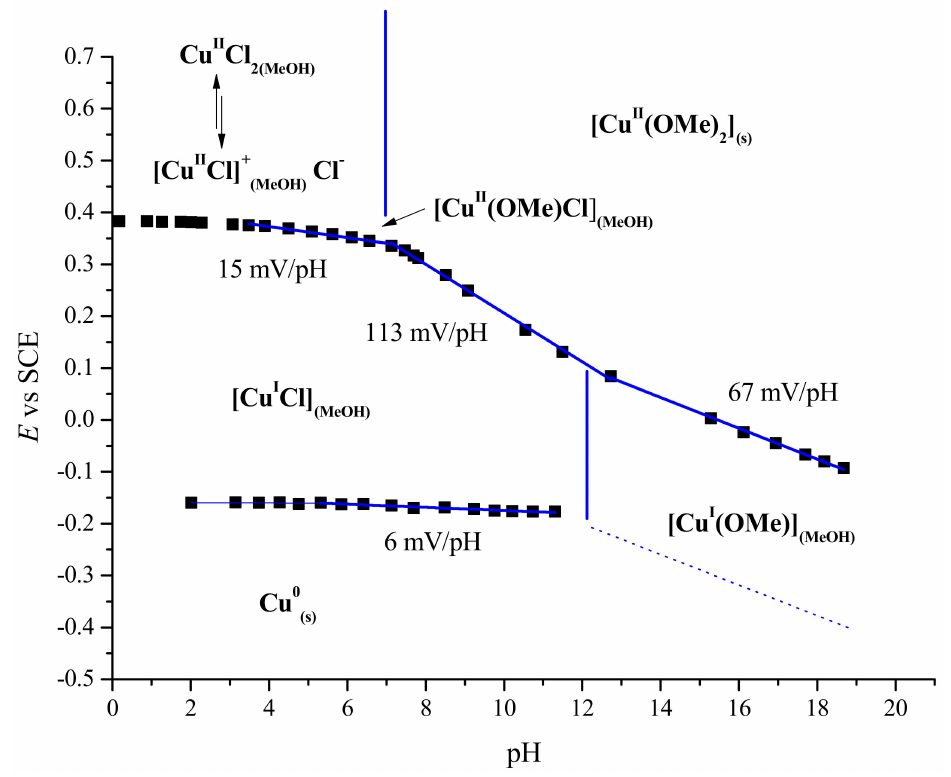
Figure 4. Pourbaix diagram of Cu(I) and Cu(II) in MeOH (Cu(I) and Cu(II) concentration 2